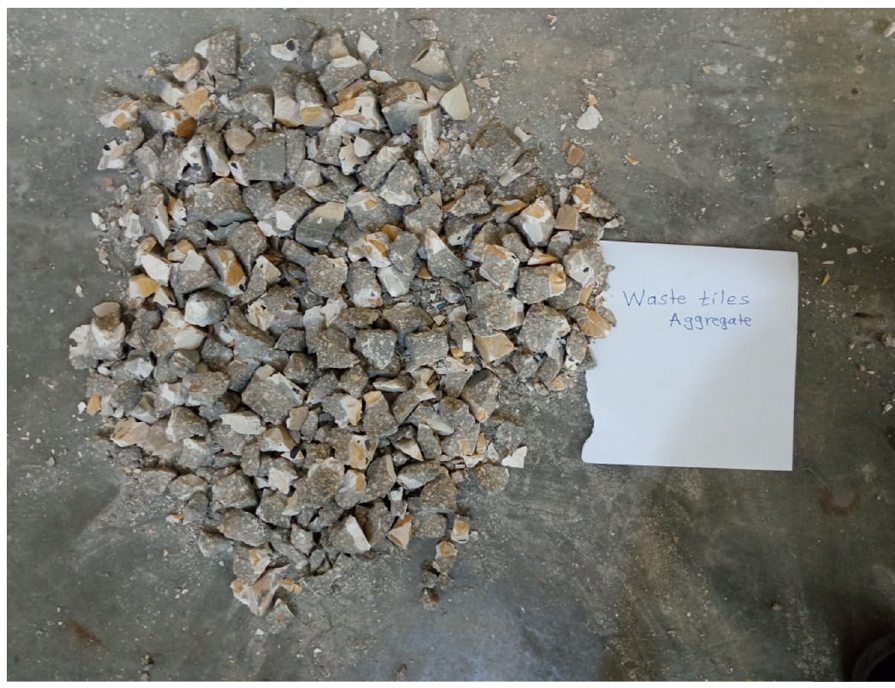
Figure 1: Waste ceramic after crushing, used as a coarse aggregate in concrete.